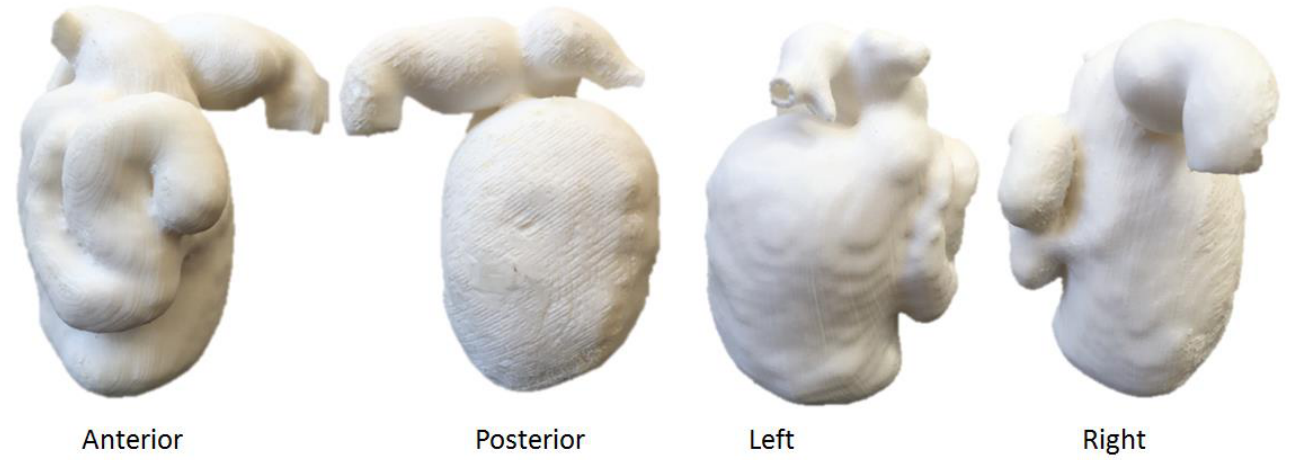
Figure 21. 3D-printed biliary cyst and bile ducts from different viewing angles.